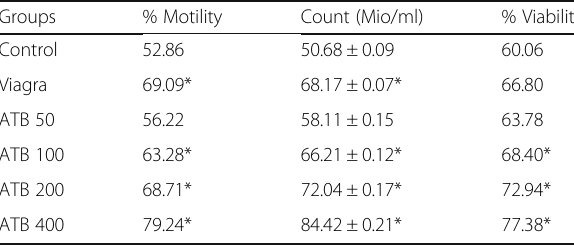
Table 3 Effect of ATB on sperm motility, count and viability Groups